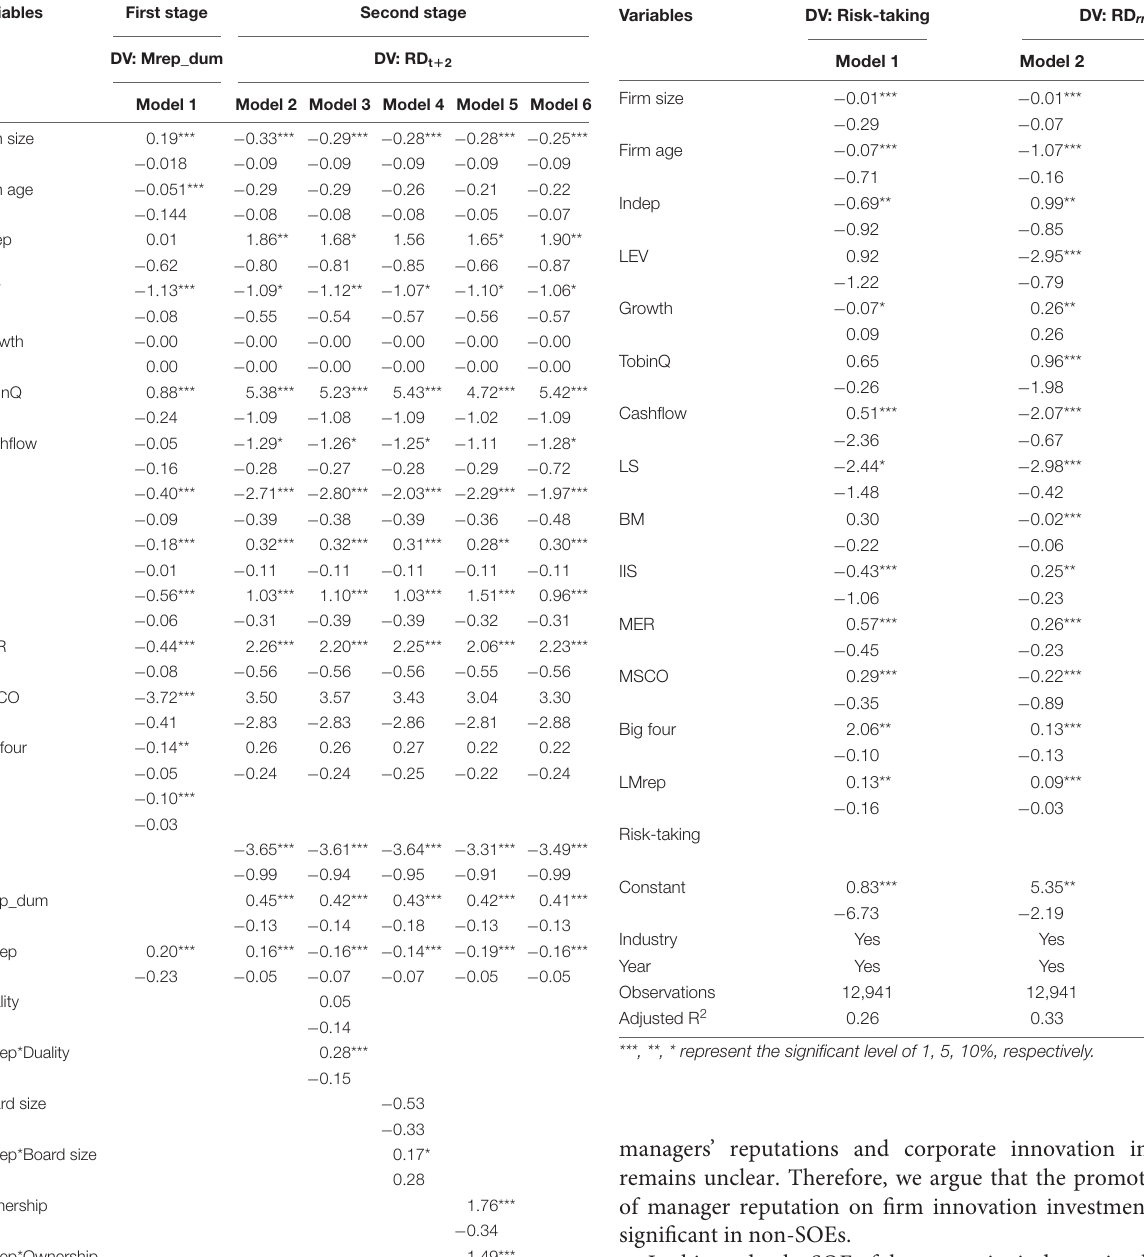
TABLE 7 | Robustness test: managerial reputation, risk taking, and innovation